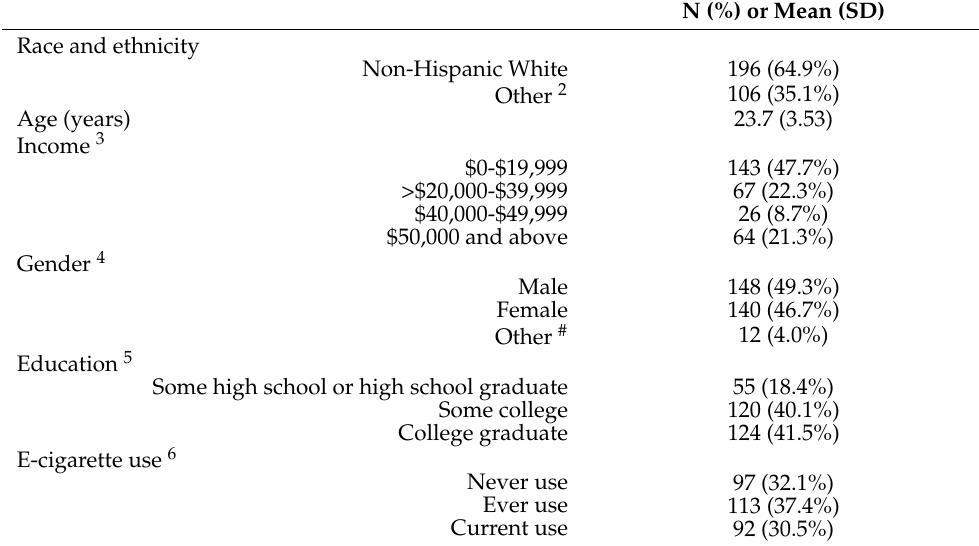
Table 1. Sample characteristics, n = 302 young adults, 2021 1 .